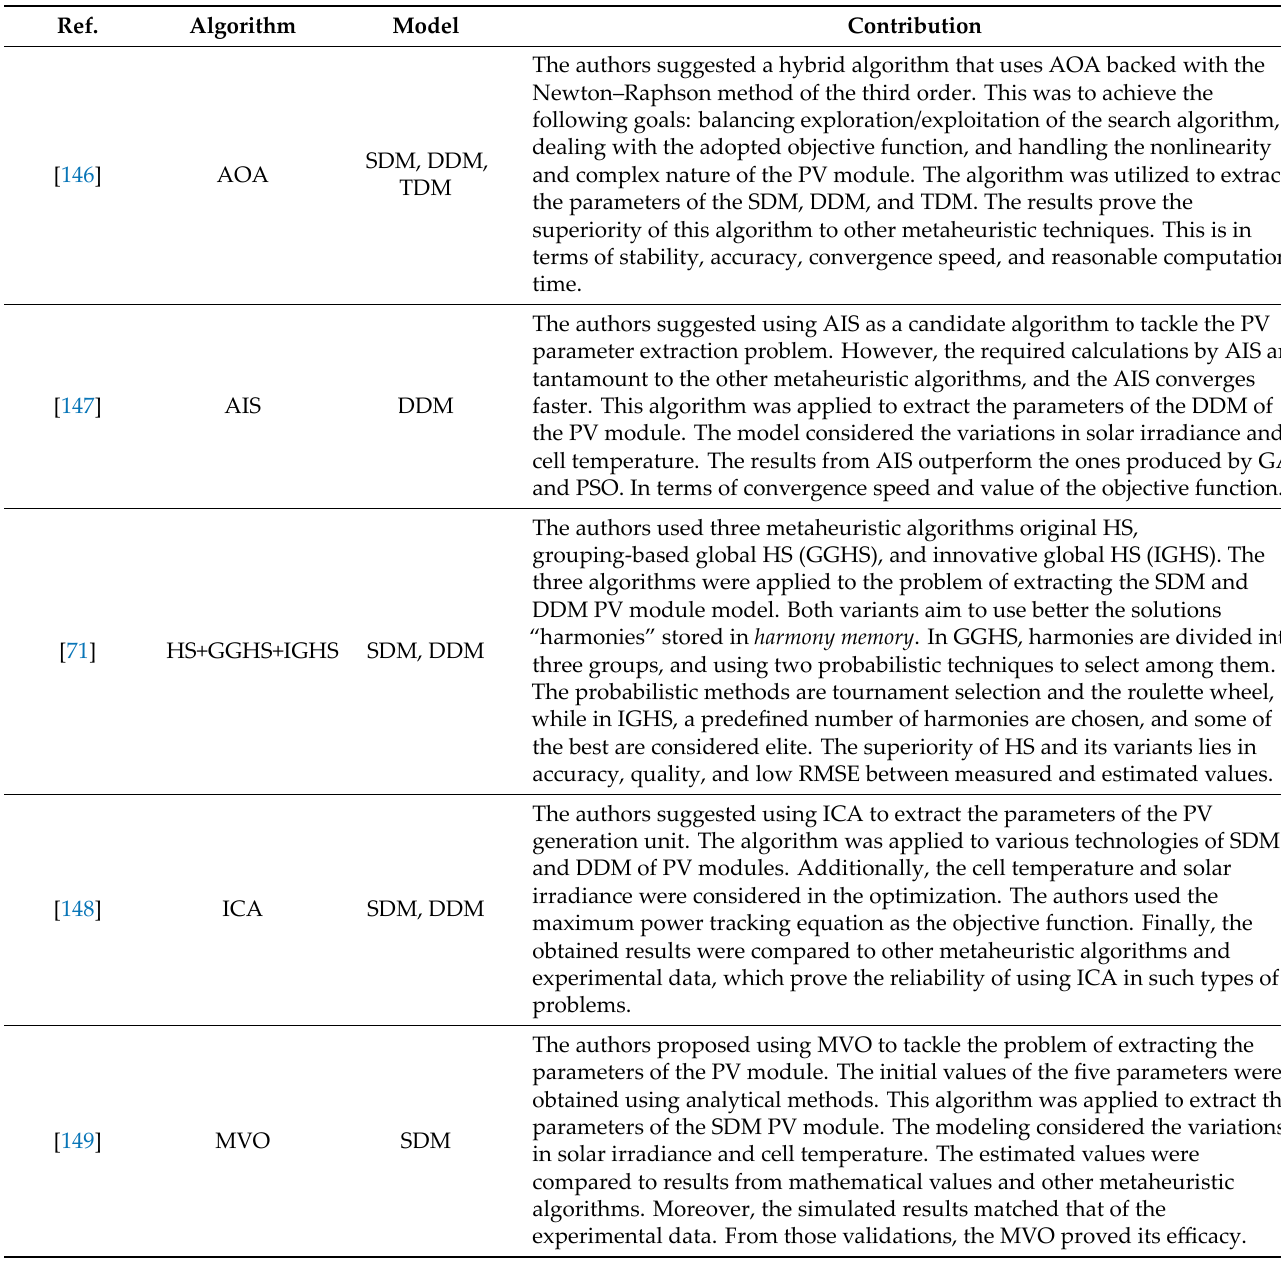
Table 8. Soft computing algorithms—human‑based metaheuristic algorithms. Ref.